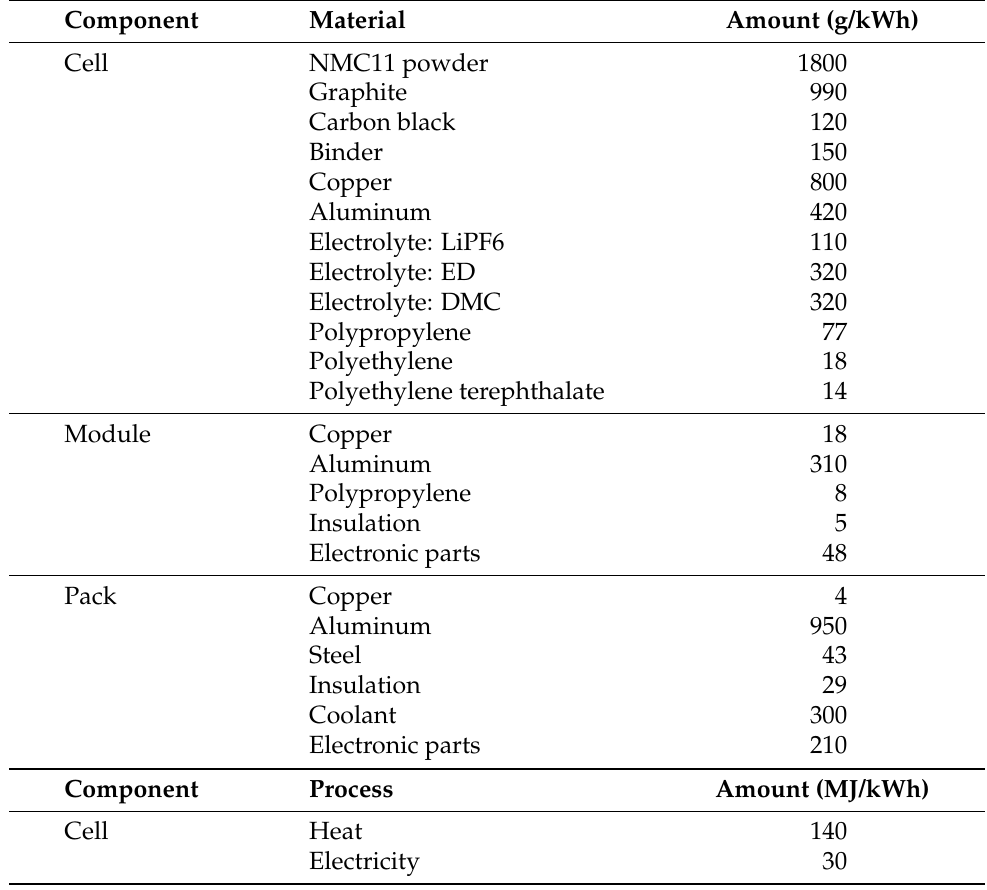
Table 1. Materials and energy needed for battery storage system production per kWh (data retrieved from